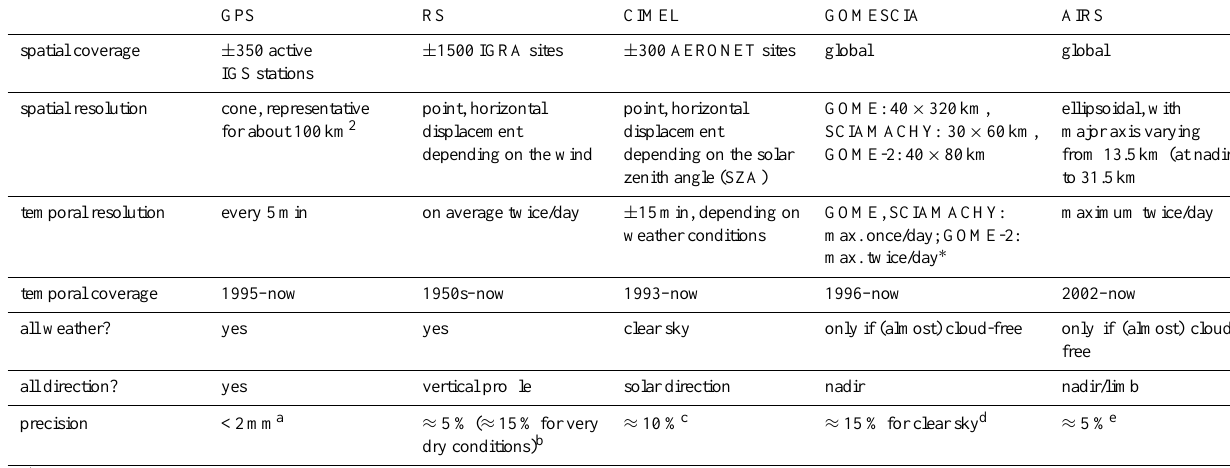
Table 1. Main characteristics of the different techniques used.